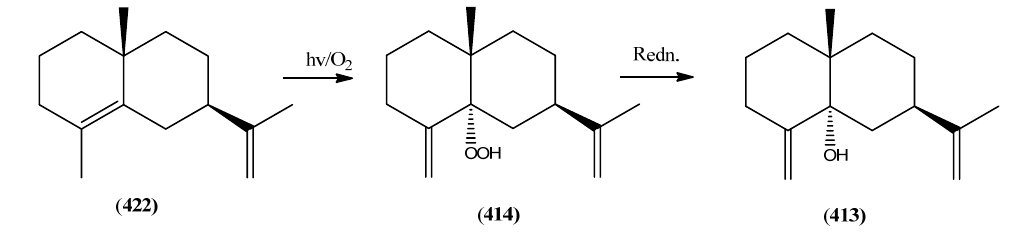
34. Eudesmane (Selinane) Sesquiterpenoids (Decahydro-1,4 α